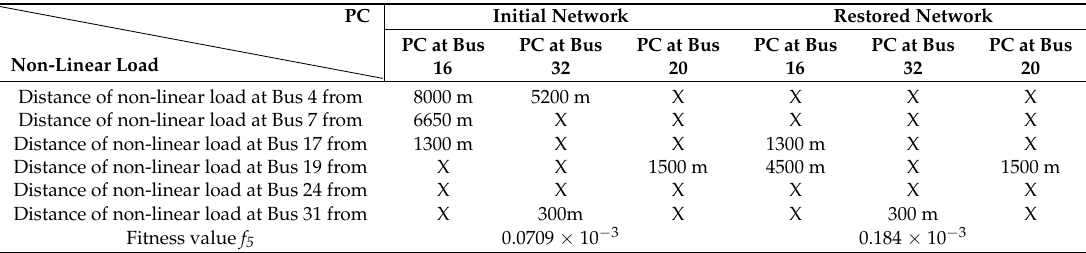
Table 4. Comparison of the total distance of non-linear loads from the priority buses in the initial network and in the restored network obtained through Multi-Objective Particle Swarm Optimization (MOPSO) plan.